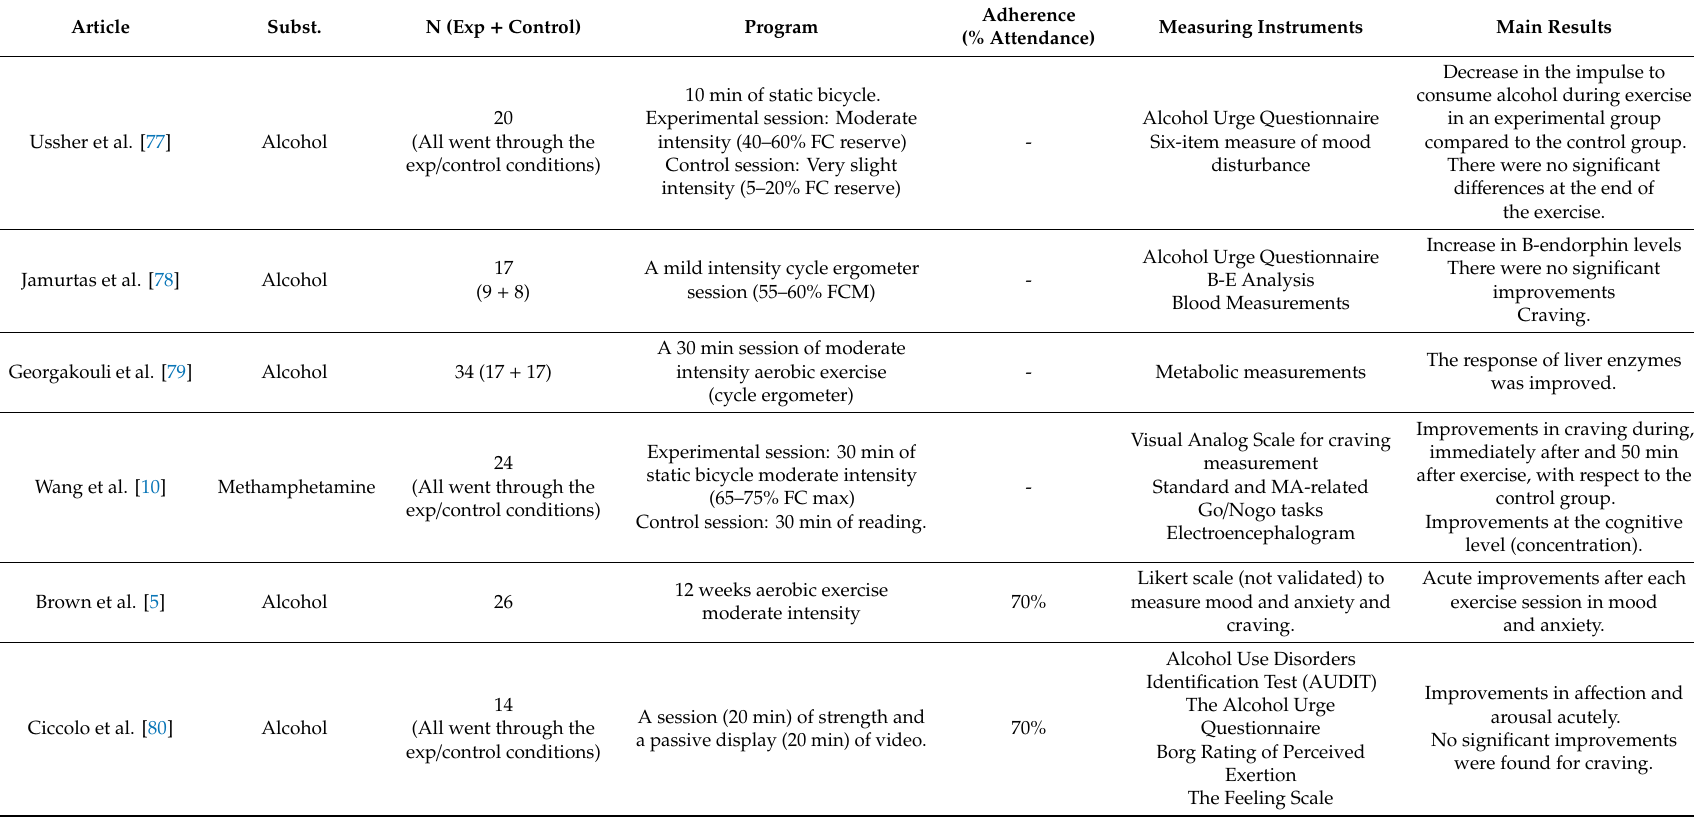
Table 2. Description of studies that measure the acute e ff ect of exercise on alcohol or other